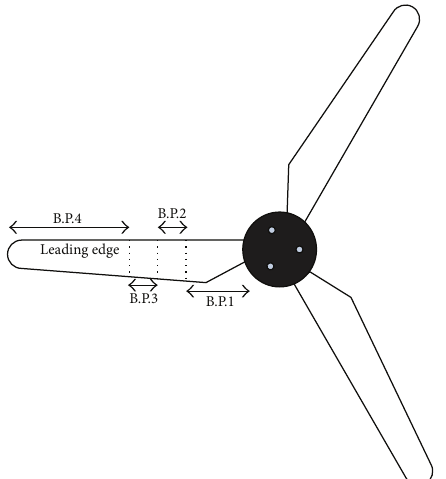
Figure 1: The blade profile distribution along the wind turbine